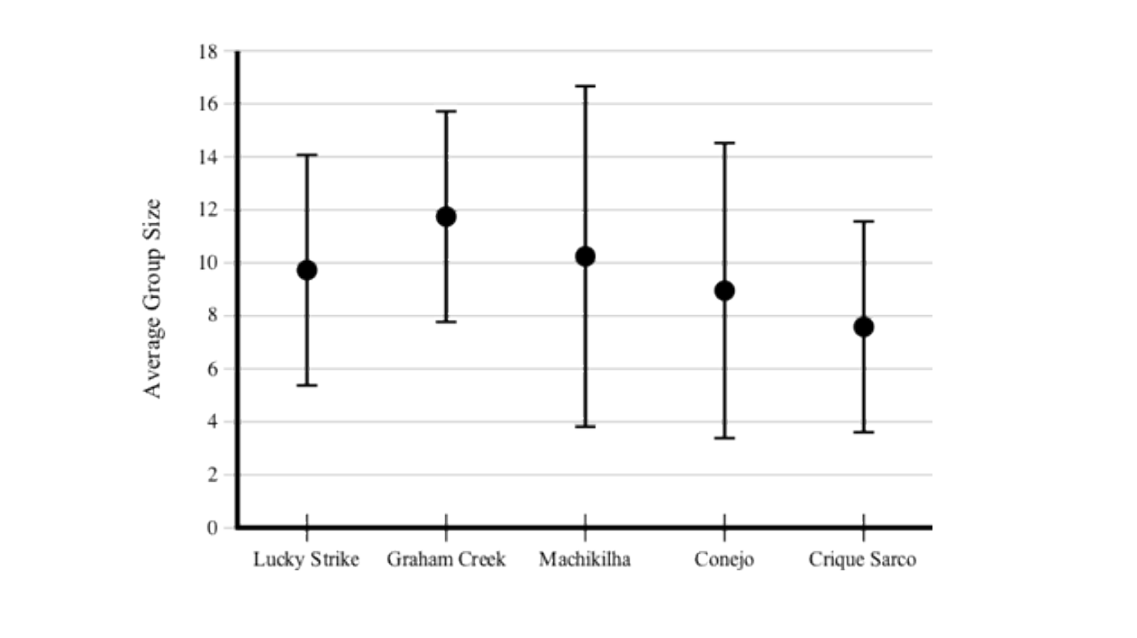
Fig. 3. Average reported labor-group sizes and standard